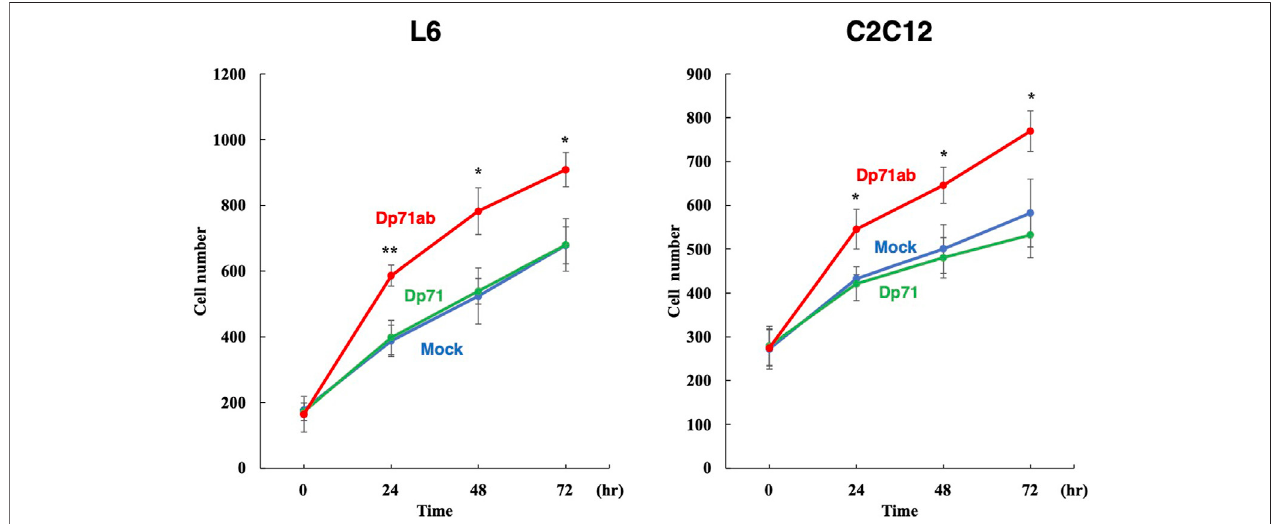
FIGURE 4 | Enhancement of L6 rat and C2C12 mouse myoblast proliferation by Dp71ab. L6 rat and C2C12 mouse myoblasts were transfected with Dp71ab, Dp71 and mock plasmids and incubated for 72 h. As expected, Dp71ab (red) signi fi cantly increased the number of L6 and C2C12 cells compared to that of the Dp71 (green) or mock (blue) transfected cells (134 and 132%, respectively). Human Dp71ab enhanced the proliferation of myoblasts across species. * = p < 0.05, ** = p <